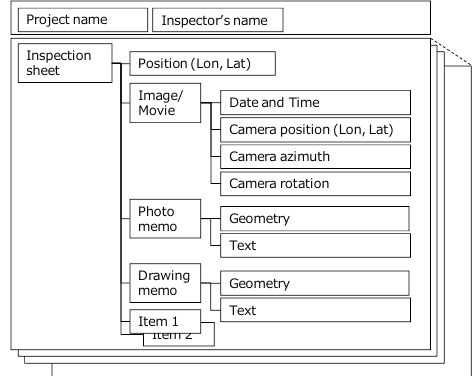
Figure 4. Data model for our Web GIS-based mobile inspection application